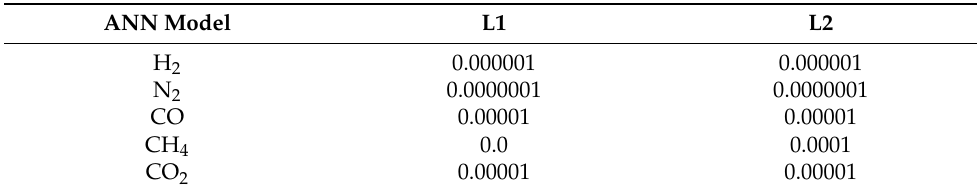
Table 7. L1 and L2 Table 7. L1 and L2 values.